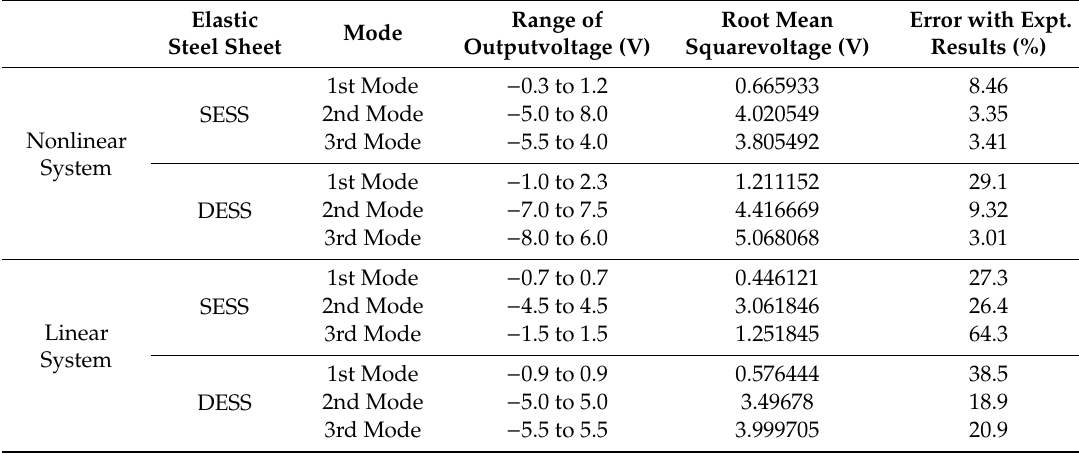
Table 7. Power benefits of linear and nonlinear